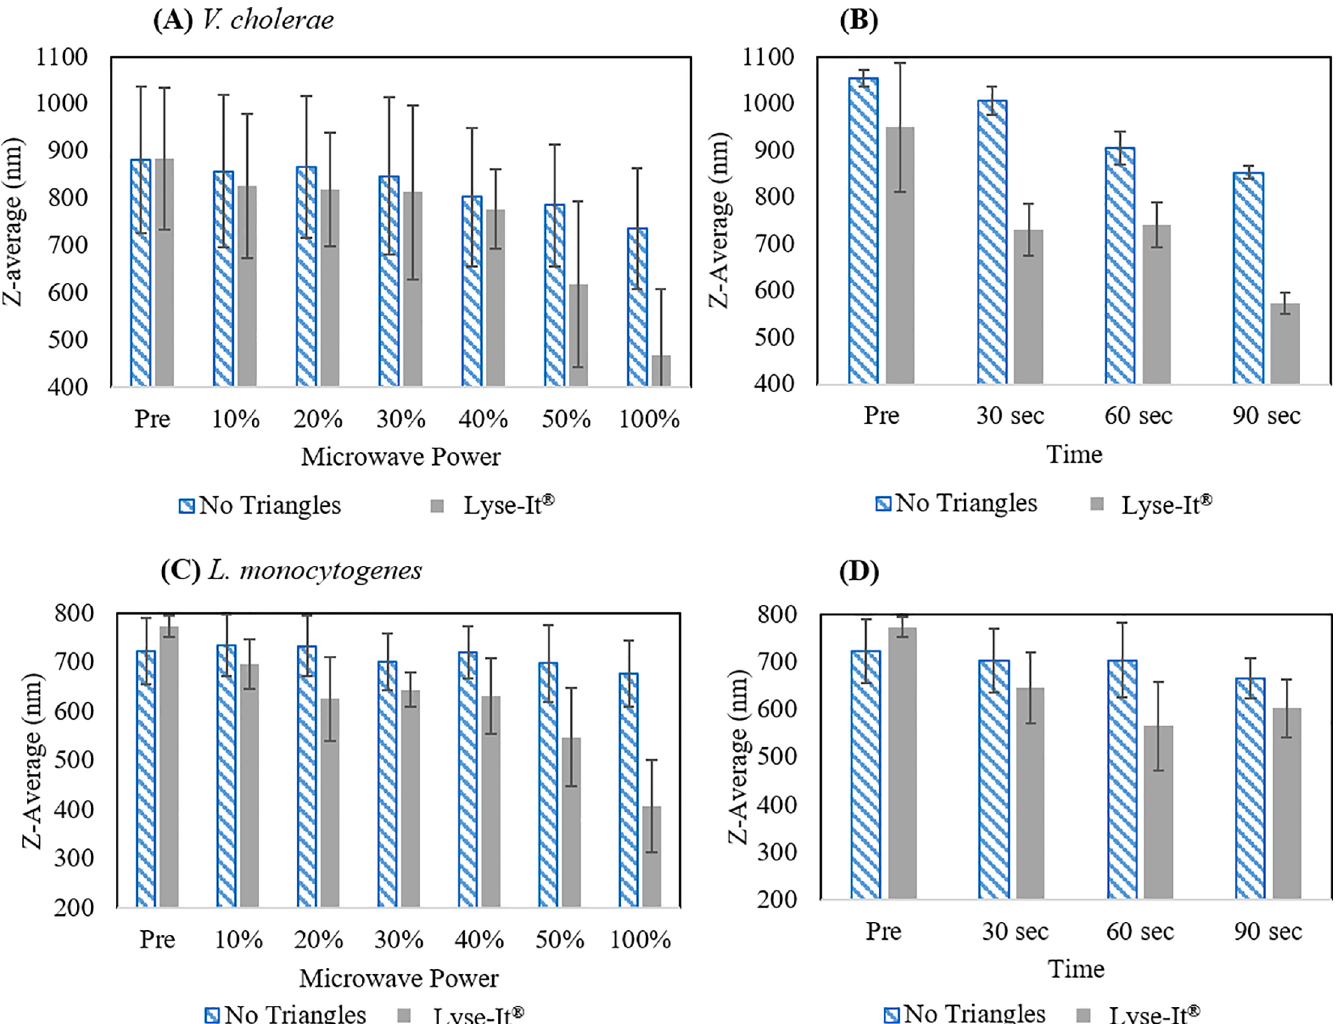
Fig 2. Dynamic Light Scattering (DLS) of microwave lysed V . cholerae and L . monocytogenes with and without Lyse-It 1 . (A) V . cholerae microwave irradiated for 60 seconds at varying powers and (B) microwaved for varying times at 30% power. (C) L . monocytogenes microwave irradiated for varying powers for 60 seconds and (D) microwaved at 50% power for varying times. It is clear that when Lyse-It 1 is used, there is a decrease in the overall cellular size indicating that cellular lysis is occurring and is more efficient with Lyse-It 1 as compared to standard microwave heating.